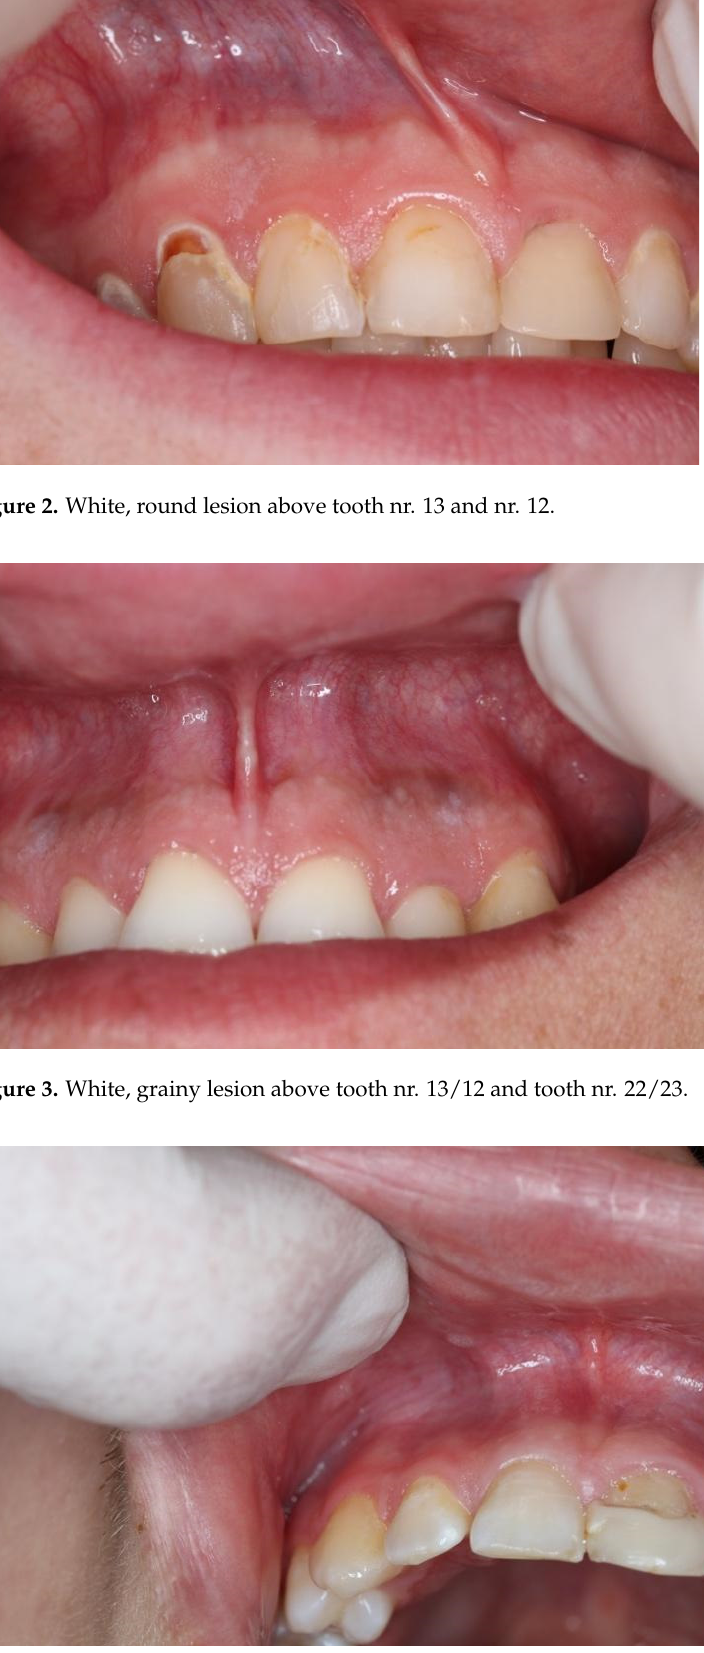
Figure 4. White, linear lesions in the right vestibule. Table 3. The patterns of mucosal changes of respondents.